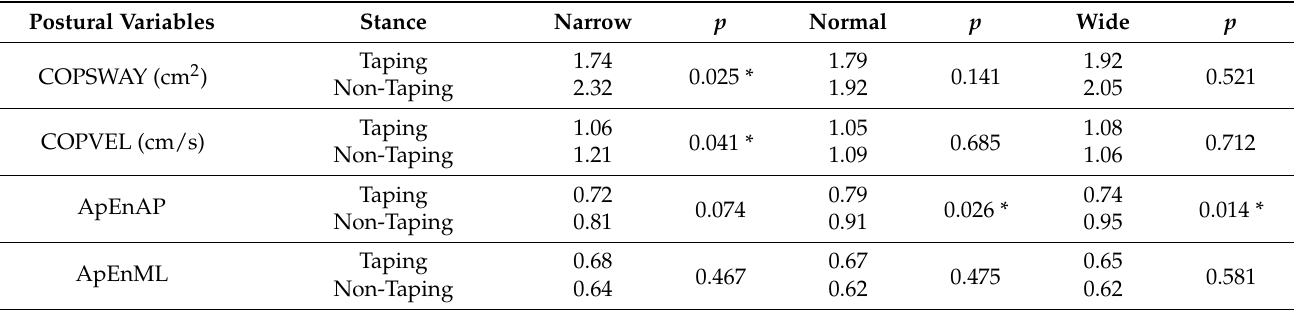
Table 1. Mean, standard deviation and p-value from paired t -tests for all dependent variables including COPSWAY, COPVEL, ApEnAP and ApEnML. p < 0.05 for difference between taping and non-taping